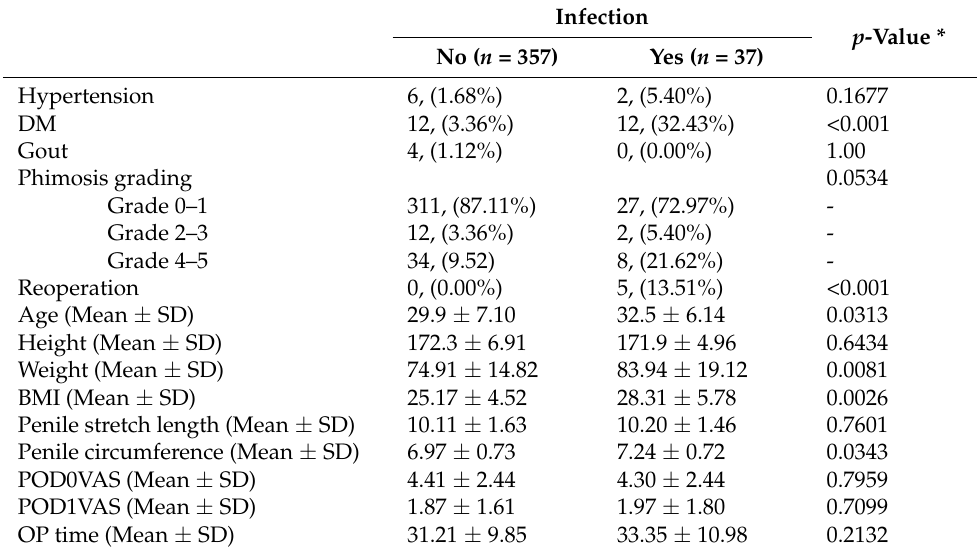
Table 3. Comparative wound infection and non ‐ infection group.